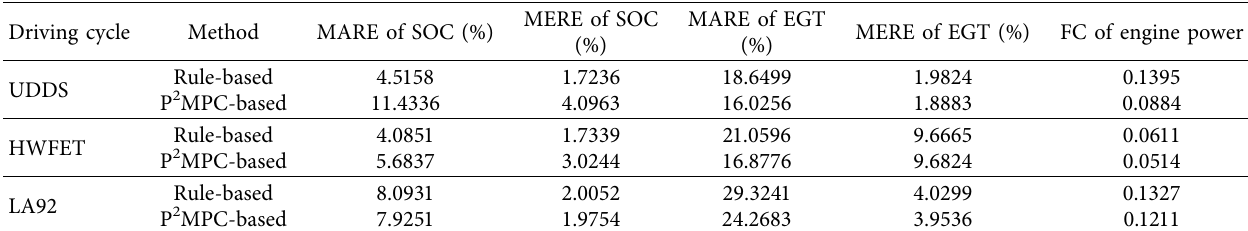
Figure 23: Simulation results comparison based on LA92. (a) SOC of power battery. (b) EGT of turboshaft engine. (c) Output power of turboshaft engine. Table 11: Simulation results